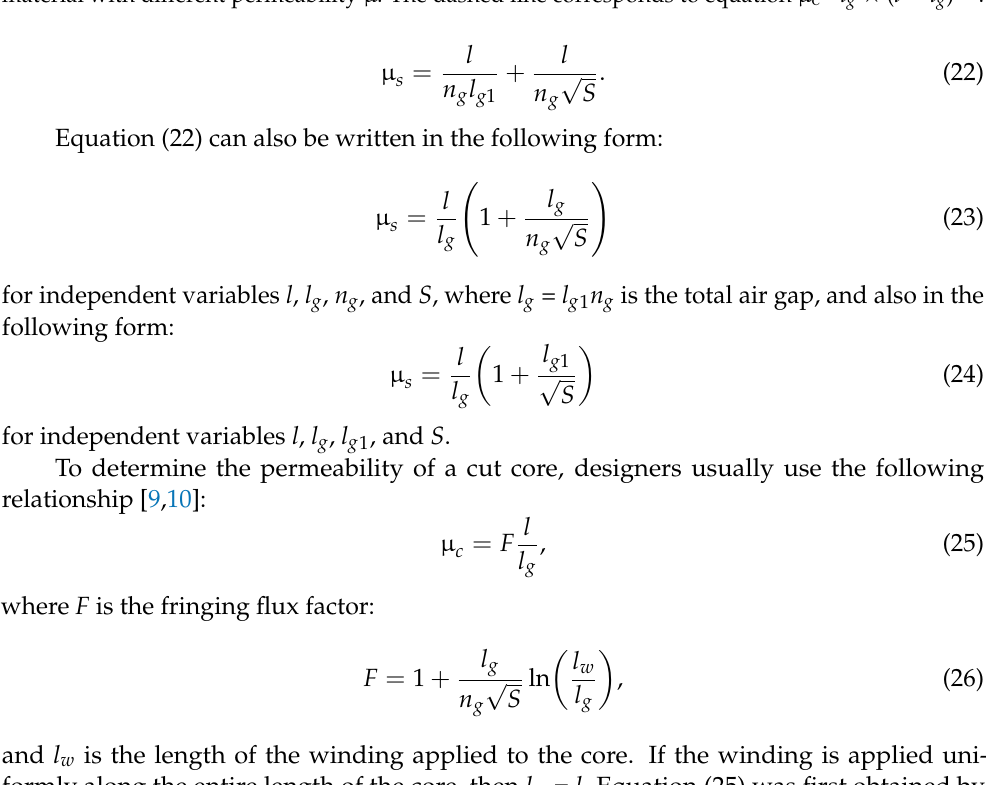
Figure 1. Dependences of the annular core permeability µ с on the l g × ( l − l g ) − 1 ratio for magnetic material with different permeability µ . The dashed line corresponds to equation µ с = l g × ( l − l g ) − 1